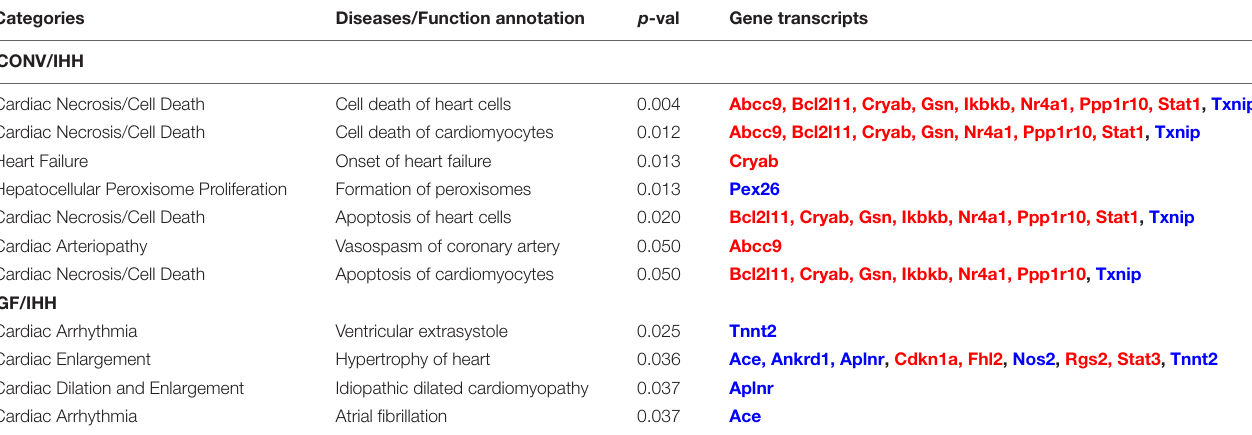
TABLE 2 | Transcriptome indication of potential IHH-induced cardiac disorders in GF and CONV